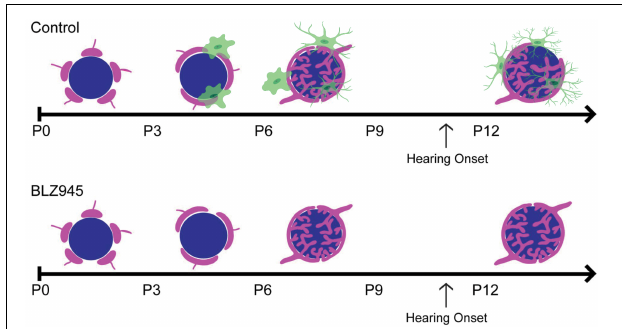
FIGURE 2 | (Top) Schematic representation of calyceal pruning during the first two postnatal weeks. Proto-calyces (magenta) innervate MNTB cells (blue) and are eliminated until a single dominant input remains. Microglia (green) are seen near calyces and display mature morphology after hearing onset. (Bottom) Microglia elimination with BLZ945 impairs calyceal pruning and leads to higher levels of polyinnervated MNTB neurons. Adapted from Milinkeviciute et al.